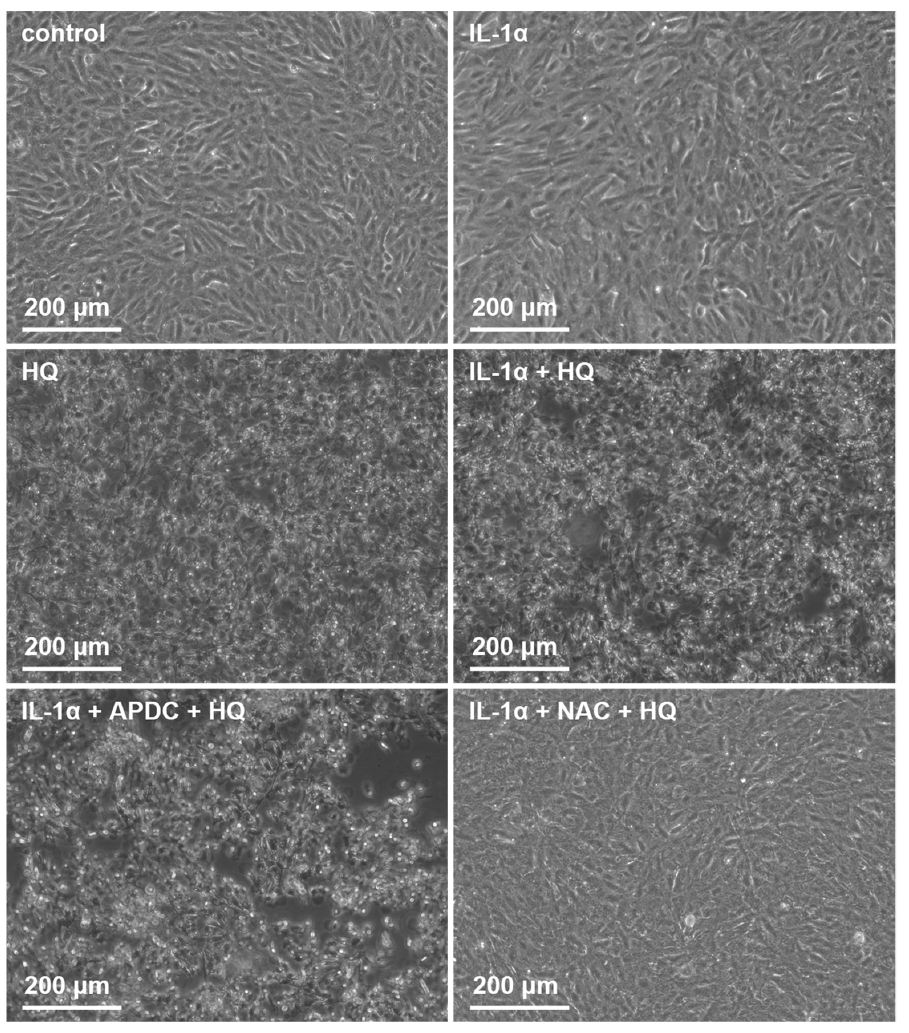
Figure 8. The effect of 200 μ M hydroquinone (HQ; 18 h) on ARPE-19 cells with and without IL-1 α - priming and antioxidants (2 μ M APDC, 5 mM NAC). Cells were visualized using the Axio Vert A1 Zeiss microscope with AxioCam MRm camera and Zen 2011 program (Carl Zeiss Microscopy GmbH, Jena,